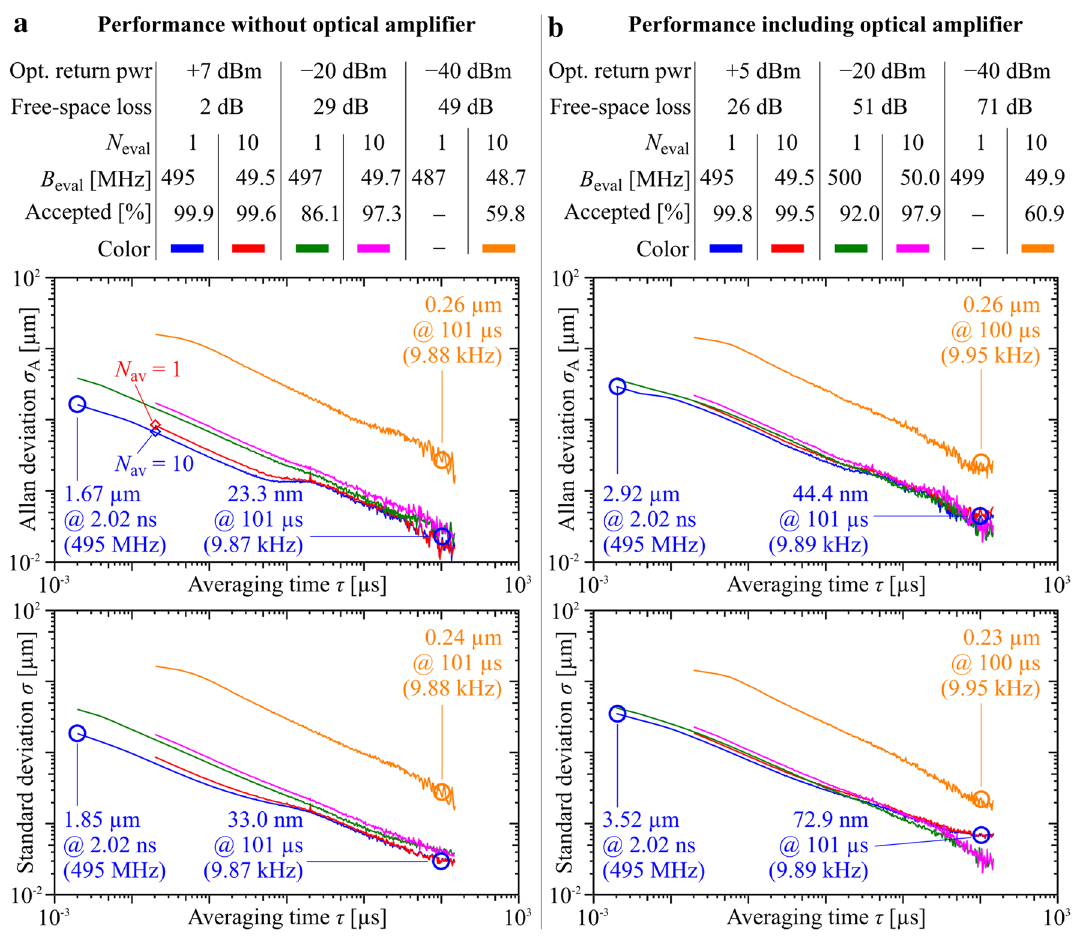
Figure 3. Performance of ranging system for varying optical return powers, with and without booster optical amplifier (EDFA), see Fig. 2a for the underlying experimental setup and Section ‘Detailed description of experimental setups’ of the Supplementary Information for further details. ( a ) Performance without EDFA. The table lists the optical return power, the associated round-trip loss in the free-space path, the number N eval of repetition periods T r used for signal evaluation per distance data point, the corresponding evaluation bandwidth B eval , and the percentage of accepted data points. The upper plot shows the Allan deviation as a function of distance averaging time τ for all five configurations, and the lower diagram depicts the standard deviation. Deviations of less than 2 µm were demonstrated at record-high effective measurement rates of up to 495 MHz. ( b ) Same as ( a ), but with an optical booster amplifier (EDFA), which increases the tolerance with respect to optical losses and therefore permits a longer measurement reach compared to ( a ). At an effective measurement rate of 10 kHz, we demonstrate reliable ranging with standard deviations of less than 1 µm for free-space losses of more than 70